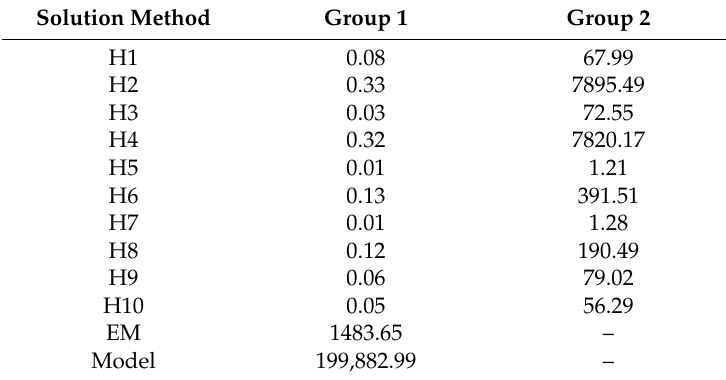
Table 12. Computational efficiency (average CPU times in